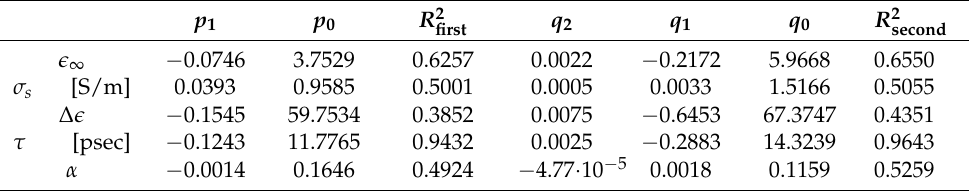
Table 1. Parameters of the polynomial fit of the Cole–Cole parameters for the first ( p 1 T 2 + q 1 T + q 0 ) with the corresponding goodness of fit values ( R 2 ). second order ( q 2 × ×